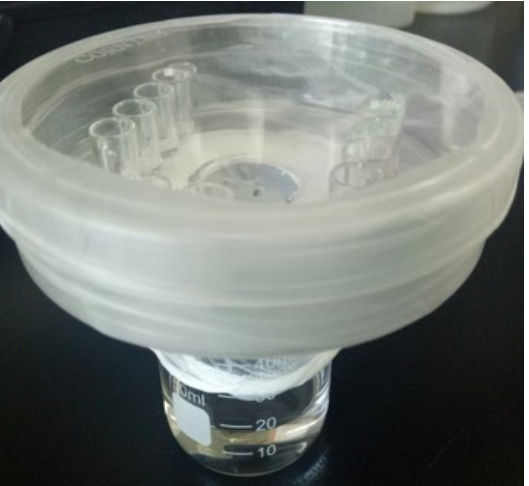
Figure 6. Experimental setup used for calcite crystal growth in vitro.